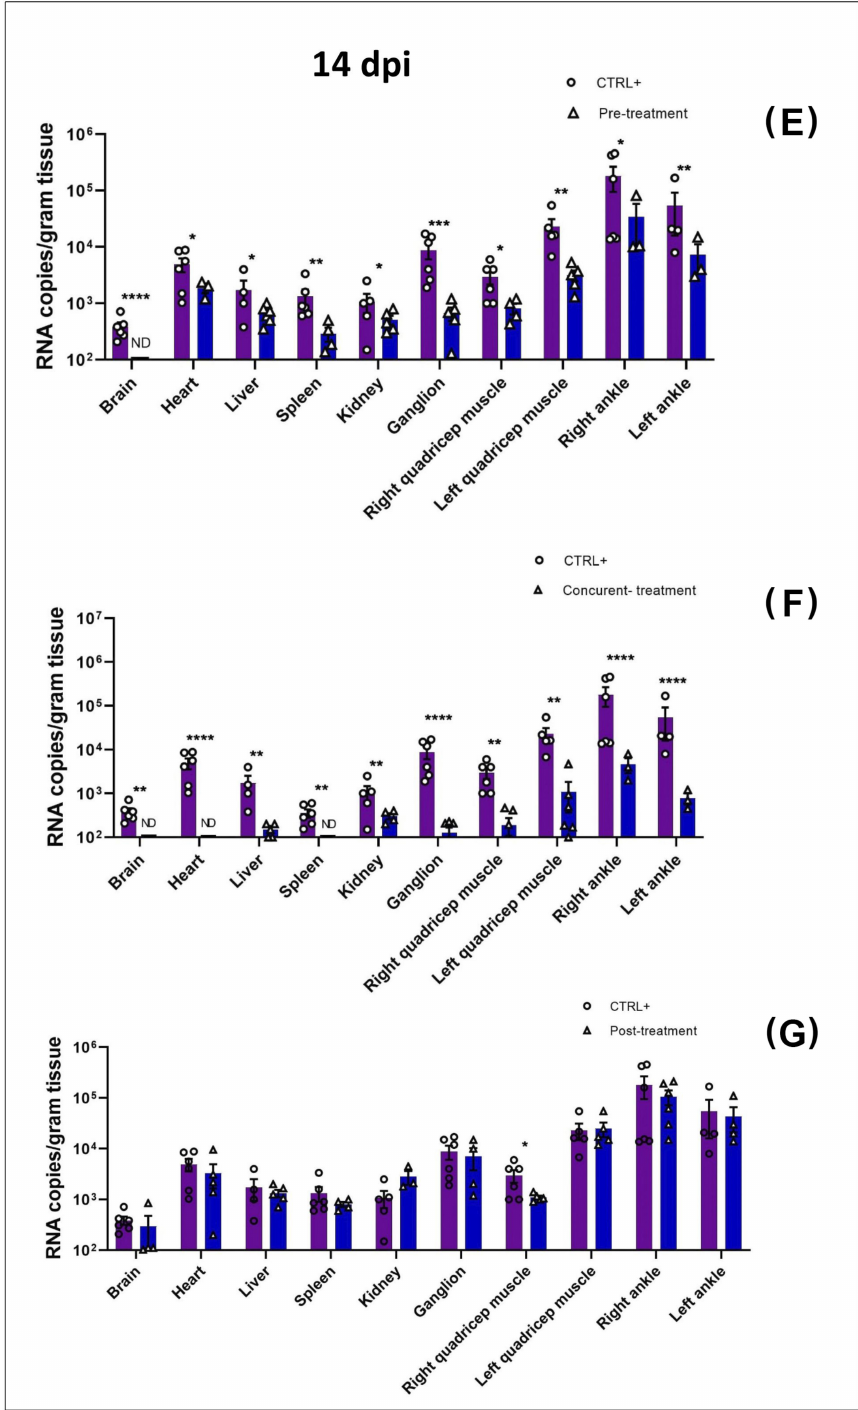
Figure 5. Favipiravir treatment decreased MAYV yield in multiple organs. MAYV-infected four-week-old mice were orally pre-, concurrently and post-treated with Favipiravir 300 mg/kg once daily for 5 consecutive days, or not treated at all. Tissues were harvested and subjected to RT-qPCR and plaque assay for viral load at 7 dpi panel ( A – D ) and 14 dpi panel ( E – G ). Each treated group ( n = 4–6) was compared to the MAYV-infected group ( n = 5). In each tissue graph, dots in the figure correspond to an animal, except in the case of animals with undetectable viral loads (* p < 0.05; ** p < 0.01; *** p < 0.001; **** p < 0.0001). ND (not detected) indicates absence of infectious viral particles in the plaque assay. The bar graph is mean ± SD. Data were analyzed with the Mann − Whitney U test to test each group against the other. Each quantification value (dot) in these experiments was the mean of three